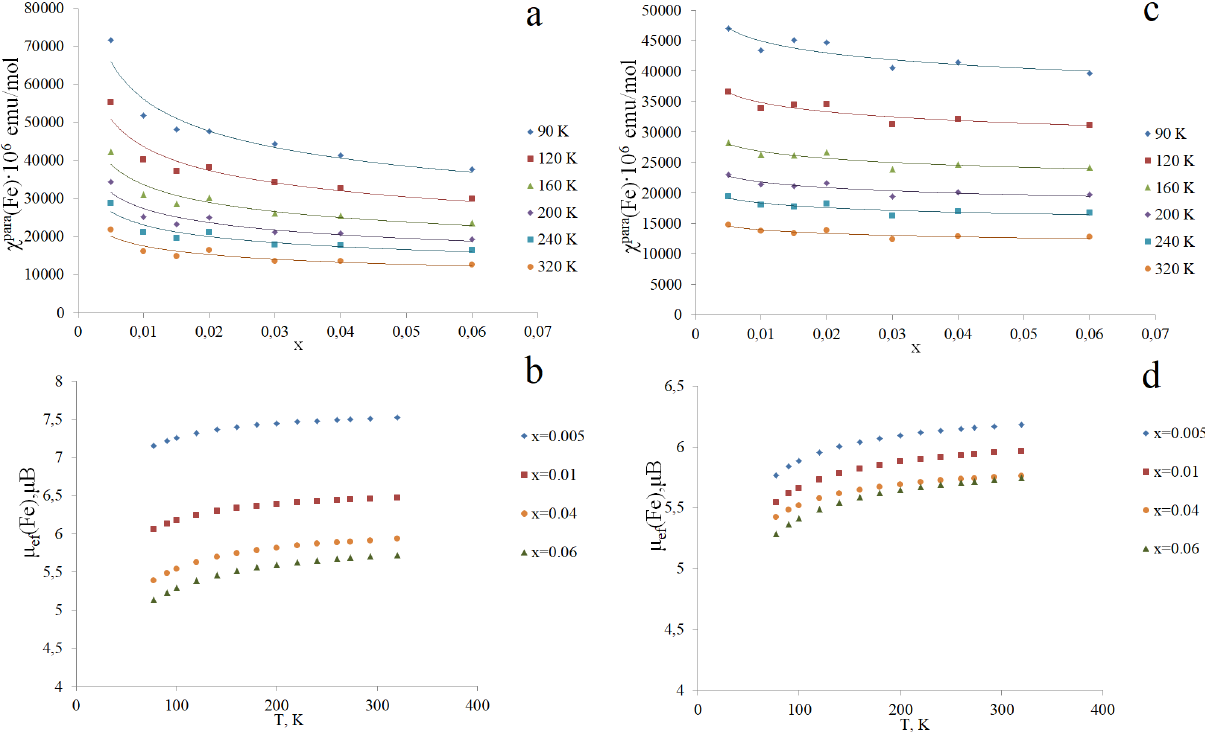
Figure 3: Isotherms of the paramagnetic component of the magnetic susceptibility of the solid solutions Bi 2 MgNb 2−2 x Fe 2 x O 9− δ (a) and Bi 2 Mg 1− x Fe x Nb 2 O 9+ δ (b); Temperature dependences of the magnetic moment of iron atoms in Bi 2 MgNb 2−2 x Fe 2 x O 9− δ (c) and Bi 2 Mg 1− x Fe x Nb 2 O 9+ δ (d)